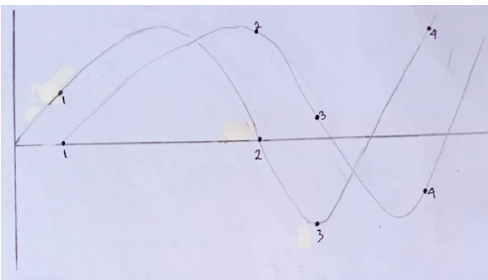
FIG. 12. A correct drawing from a student, but it did not help him to change his prior